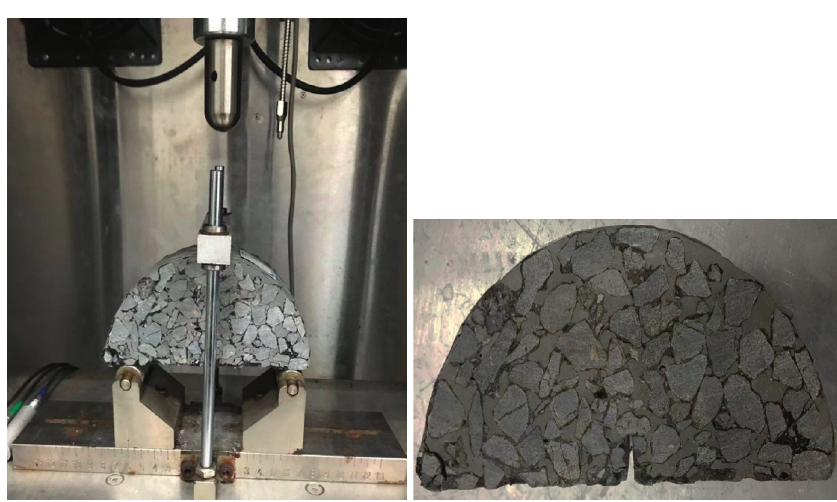
Figure 4: Samples and test setup of SCB